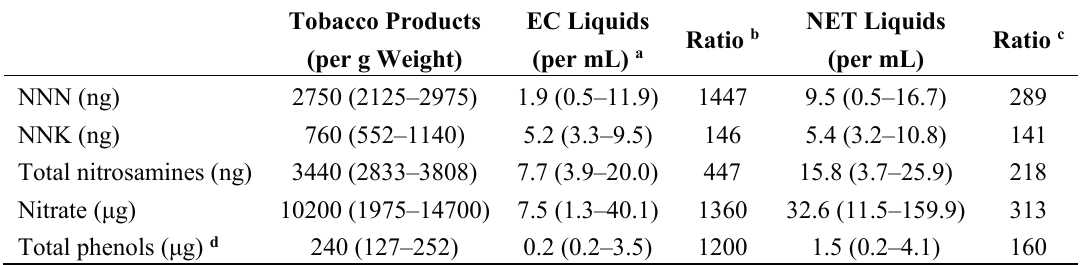
Table 3. Difference between tobacco cigarette products and electronic cigarette liquids selected tobacco-derived toxins. Statistically significant differences were found for all analyses ( p <